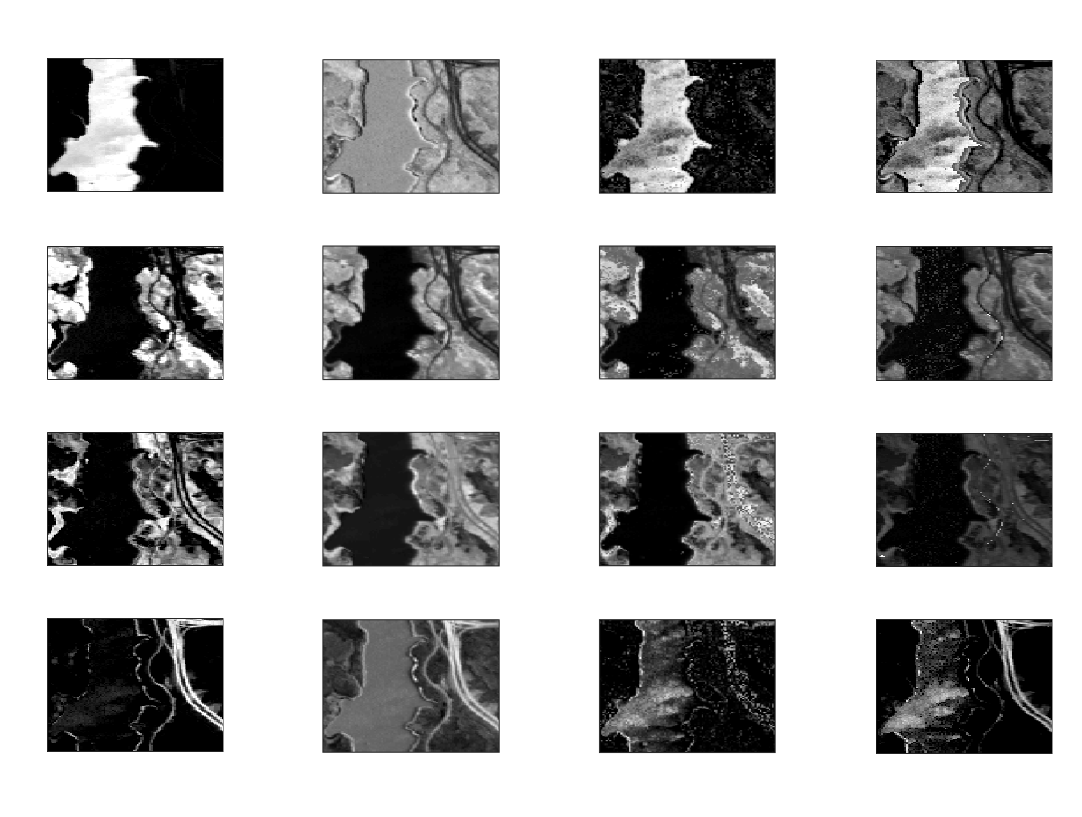
Figure 6. Abundance estimate of endmembers of the Jasper Ridge data showing from left; the groundtruth, linear (VCA), nonlinear (PPMM) and the hybrid methods. From top water ; tree ; soil ; and road